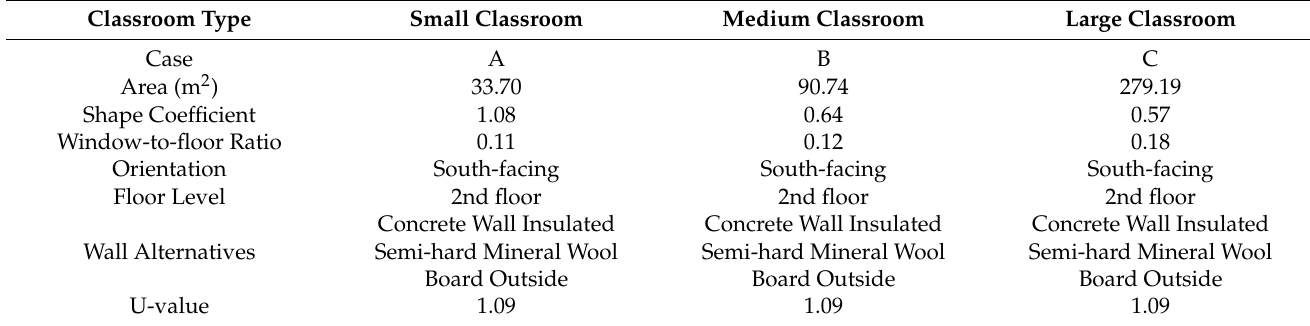
Table 2. Basic information of the case A, B, and C.